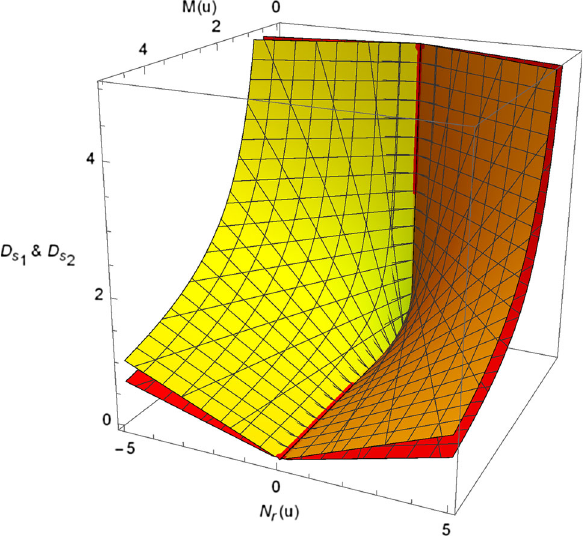
Fig. 7 The variation of D s (yellow plot) and D s (red plot) versus 1 2 typical values of the M ( u ) and N r ( u ) parameters for the radiation back- ground Fig. 8 The variation of R versus typical values of the L and N param- eters in (47) for the radiation background. We have set M = 1 without loss of